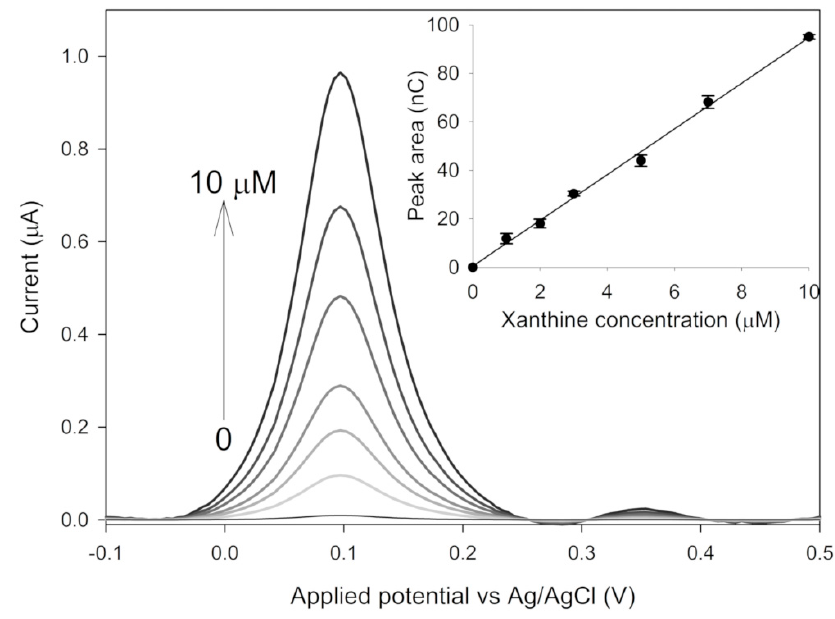
Figure 5. Square wave voltammetries and calibration plot obtained with SAMN@XO magnetically immobilized on a graphite screen-printed electrode as a function of xanthine concentration. Measurements were carried out in triplicate on the same sensor obtained by dropping 2 µL of a SAMN@XO suspension (0.25 mg mL − 1 ) in 50 mM phosphate buffer, pH 7.5. Error bars in the inset represent standard deviations.